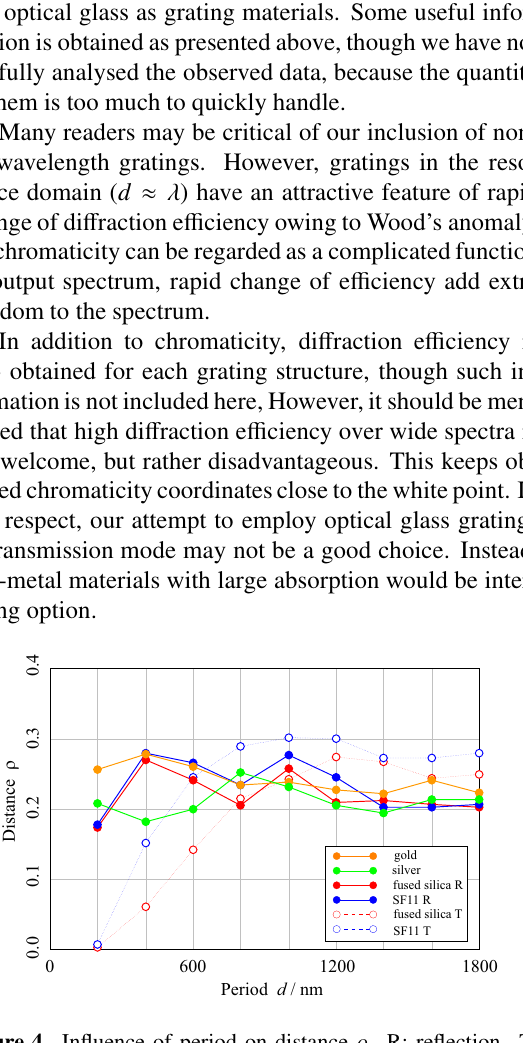
Figure 4. Influence of period on distance ρ . R: reflection. T: